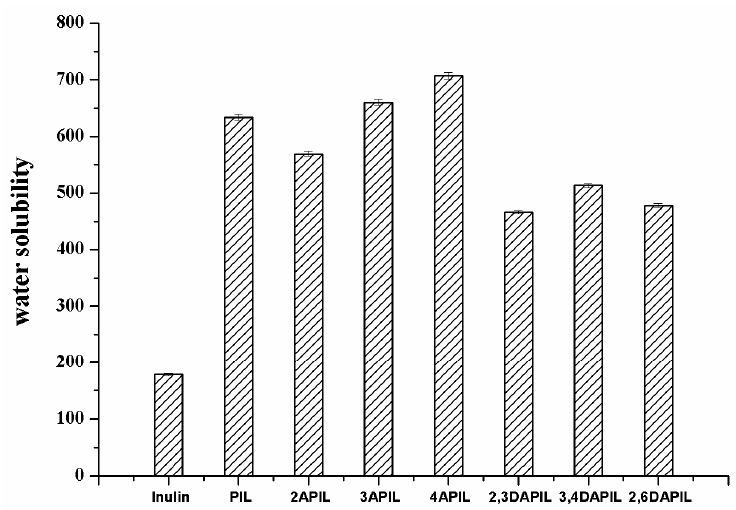
Figure 4. Water solubility of inulin and cationic inulin derivatives